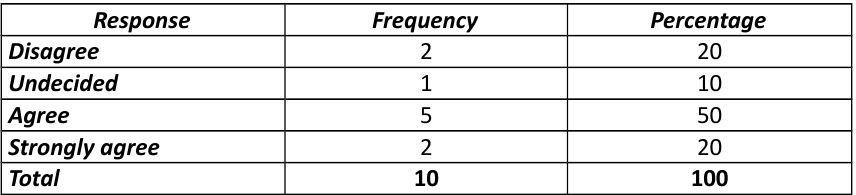
Table 5. Teacher’s inefectveness could result from students’